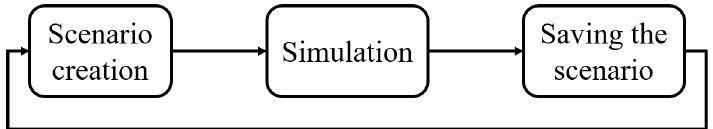
Figure 12. Diagram of driving